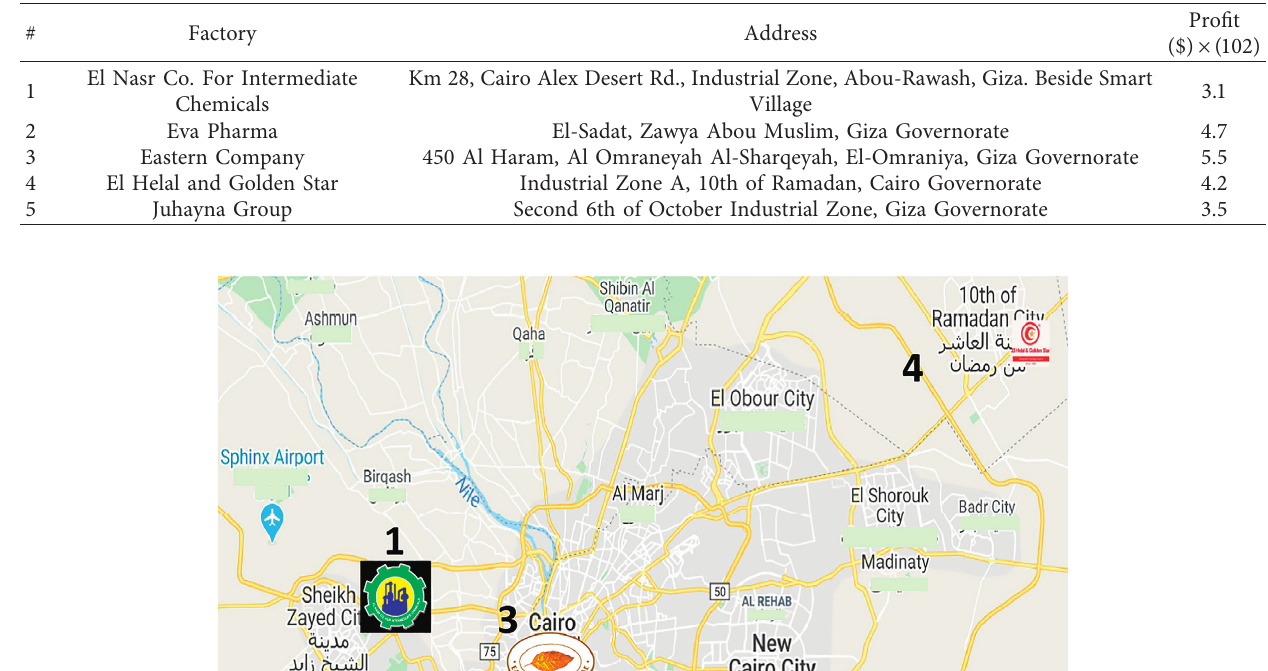
Table 1: Workplaces for the case study.